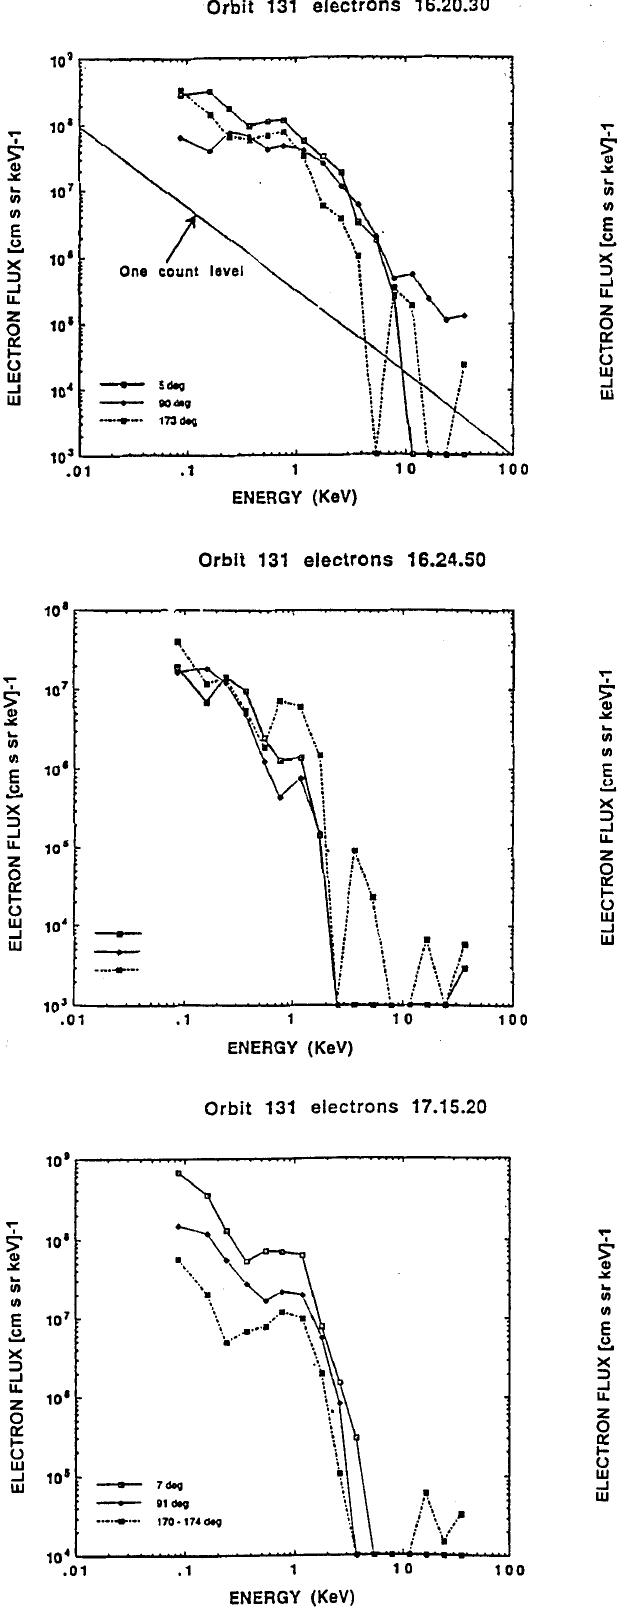
Fig. 6a. Electron spectra for different pitch-angles observed at mid-altitude by Viking on the pass shown in Fig. 5. The spectra were measured close to 0 ◦ , 90 ◦ and 180 ◦